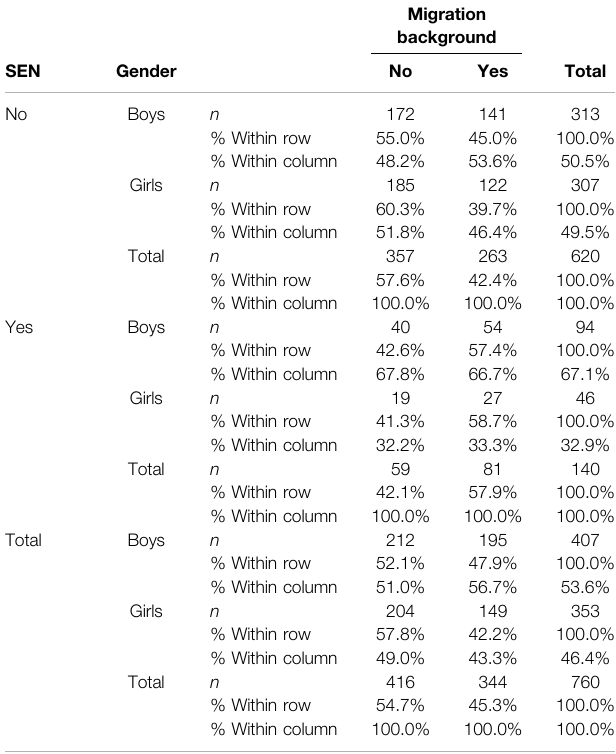
TABLE 1 | Contingency table of background